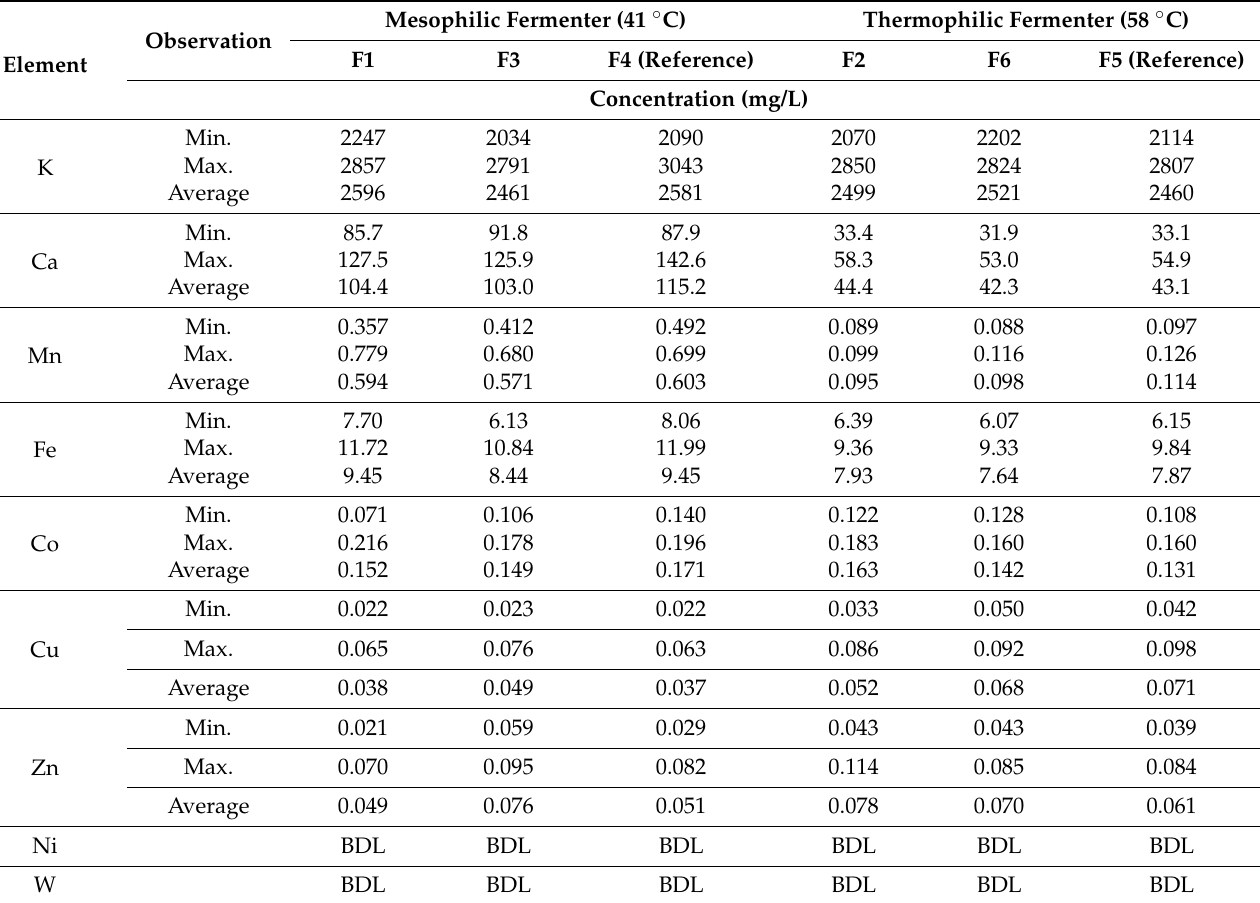
Table 3. Overview of relevant dissolved trace elements ions (Mn, Fe, Co, Cu, Zn, Ni, and W) during the monitored straw fermentation period of 640 days, as seen in Figures 1–3. TXRF-analyses were performed every two weeks (in some periods weekly). Potassium and calcium ions (K, Ca) were chosen as a benchmark. BDL = below detection